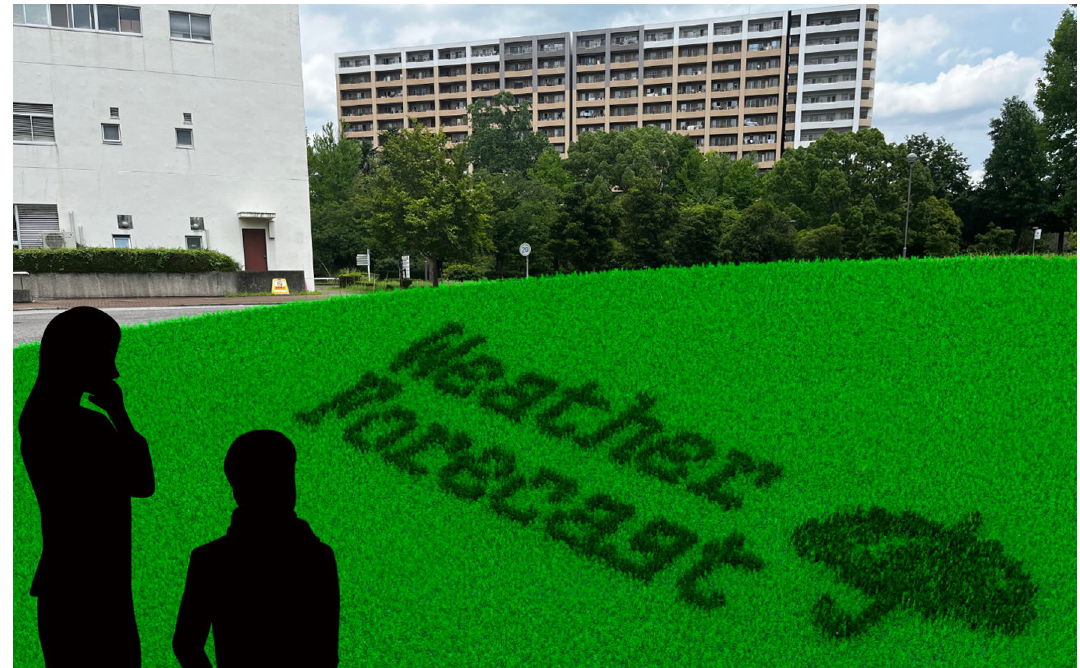
Figure 1. Concept of green landscape-friendly animation display in urban green space. The grass animation display runs a weather forecast application while preserving the green landscape of the urban green space. The background photo was captured at University of Tsukuba. The umbrella material was used in SKY’s animation (https:// pata2. jp). This figure was created using Autodesk Maya version 2023 (https:// www. autod esk. com/ produ cts/ maya/ featu res) and Serif Affinity Designer version 1.10.0 (https:// affin ity. serif. com/ en-